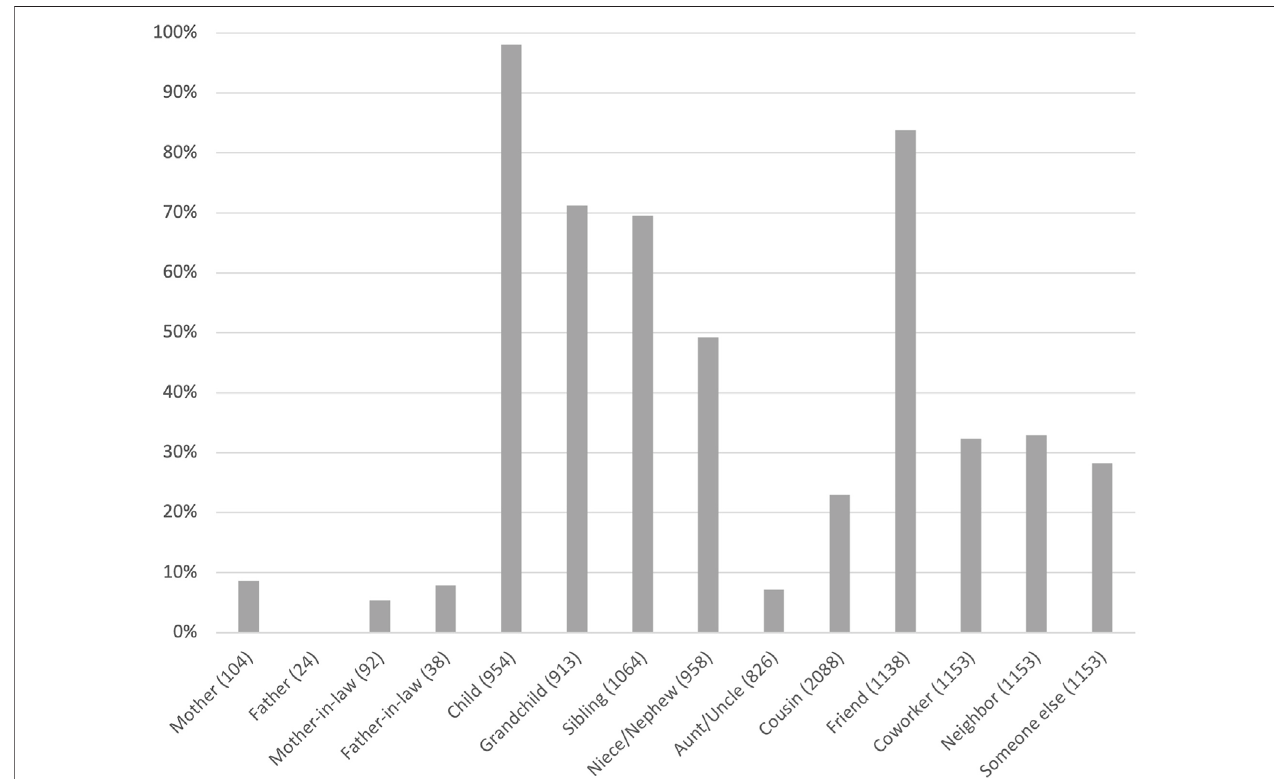
FIGURE 1 | Percentage of respondents in the older generation (aged 68 – 73) connected with kin and non-kin via social media. In the case of relatives, ( n ) indicates the number of respondents with the given relative.